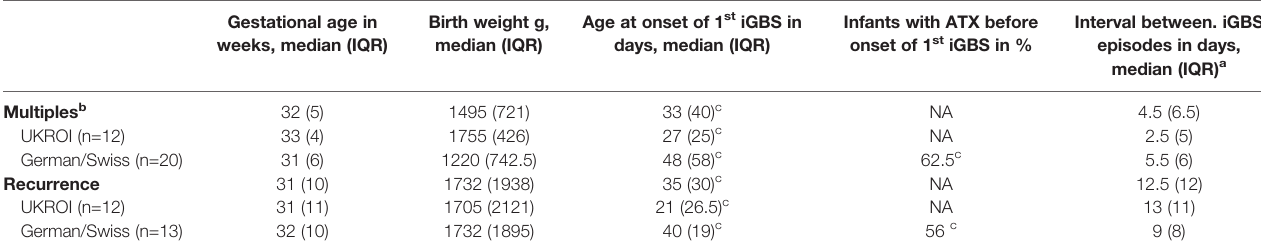
TABLE 4 | Summary of iGBS cases with recurrence and iGBS in